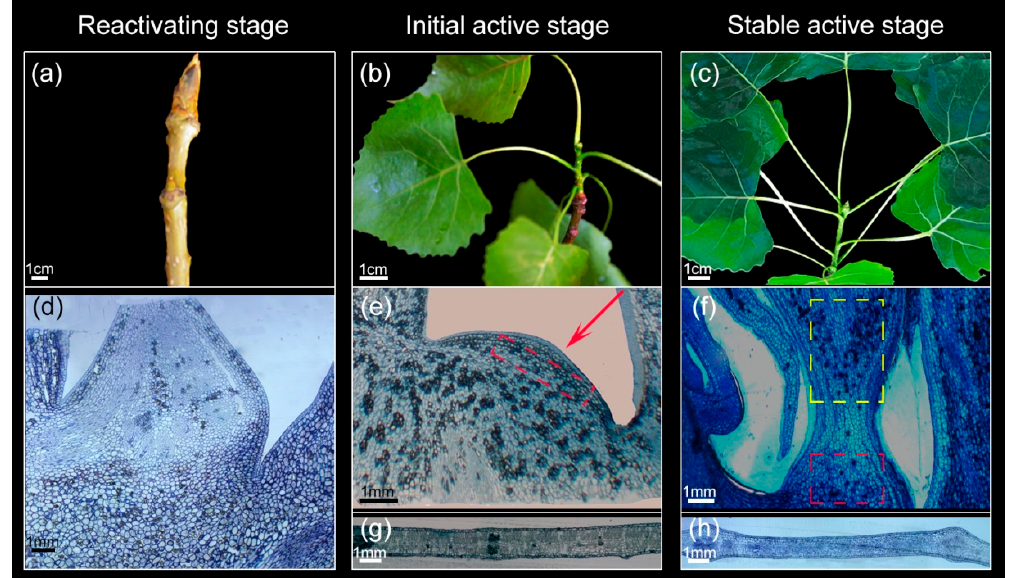
Figure 2. Morphological and anatomical structures of the shoot apical meristem (SAM) and leaves of Populus tomentosa . ( a–c ) Morphological structures of the SAM and leaves at various developmental stages. ( d ) Semi-thin section of a compound sample of the shoot tip in the reactivating stage. Micro-structures of the SAM ( e , red arrow and dashed box) and leaf ( g ) in the initial active stage. ( f ) Cross-sectional view of the SAM structures in the stable active stage (red dashed box: Shoot apex; yellow dashed box: Upward growing young leaves). ( h ) Cross-sectional view of the leaf structures in the stable active stage.